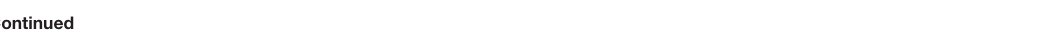
FIGURE 2 | Continued 48h after transfection with plasmids encoding the indicated proteins. *** p < 0.001 vs. control. p -values were determined by one-way ANOVA followed by Dunnett’s Multiple Comparisons test. Error bars indicate ± s.e.m from three experiments. n = 10 cells, GFP; n = 16 , NOS1AP-L; n = 12 , NOS1AP-S; n = 10 , NOS1AP-M; n = 14 , NOS1AP-L- 1 PTB; n = 11 , NOS1AP- 1 PDZ. (C) Intracellular F-actin content determined by Alexa Fluor ® 647 phalloidin fluorescence intensity 48 h after transfection of COS-7 cells with plasmids encoding the indicated proteins. *** p < 0.001 vs. Control. p -values were determined by one-way ANOVA followed by Dunnett’s Multiple Comparisons test. Error bars indicate ± s.e.m from three experiments. n = 36 cells, GFP; n = 36 , NOS1AP-L; n = 36 , NOS1AP-S; n = 36